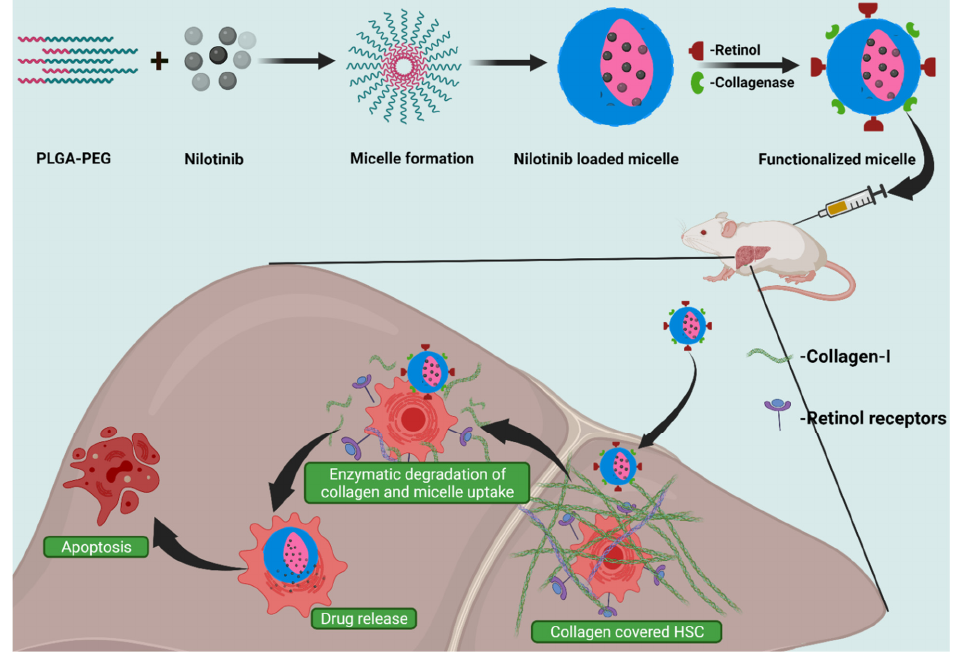
Figure 5. Design and mechanism of the action of nilotinib-loaded functionalized micelles for liver fibrosis.